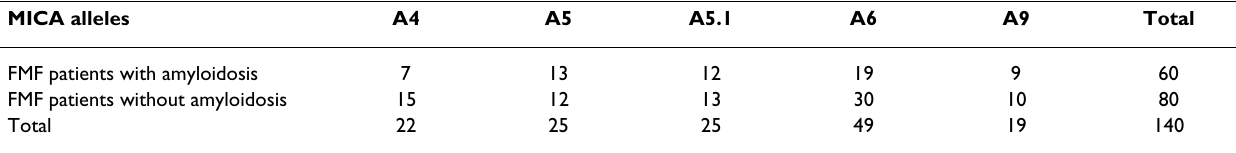
Table 3: Distribution of MICA alleles in the 2 groups of FMF patients, with and without amyloidosis (Non significant) MICA